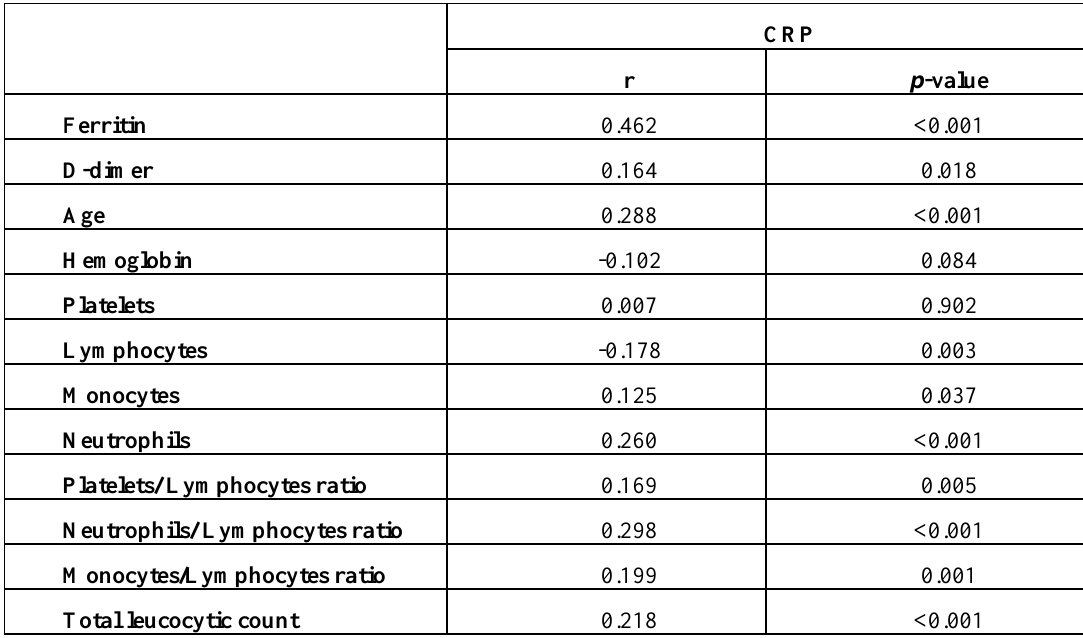
Table 4. Correlations between CRP levels and age, different CBC parameters, serum ferritin and D-dimer